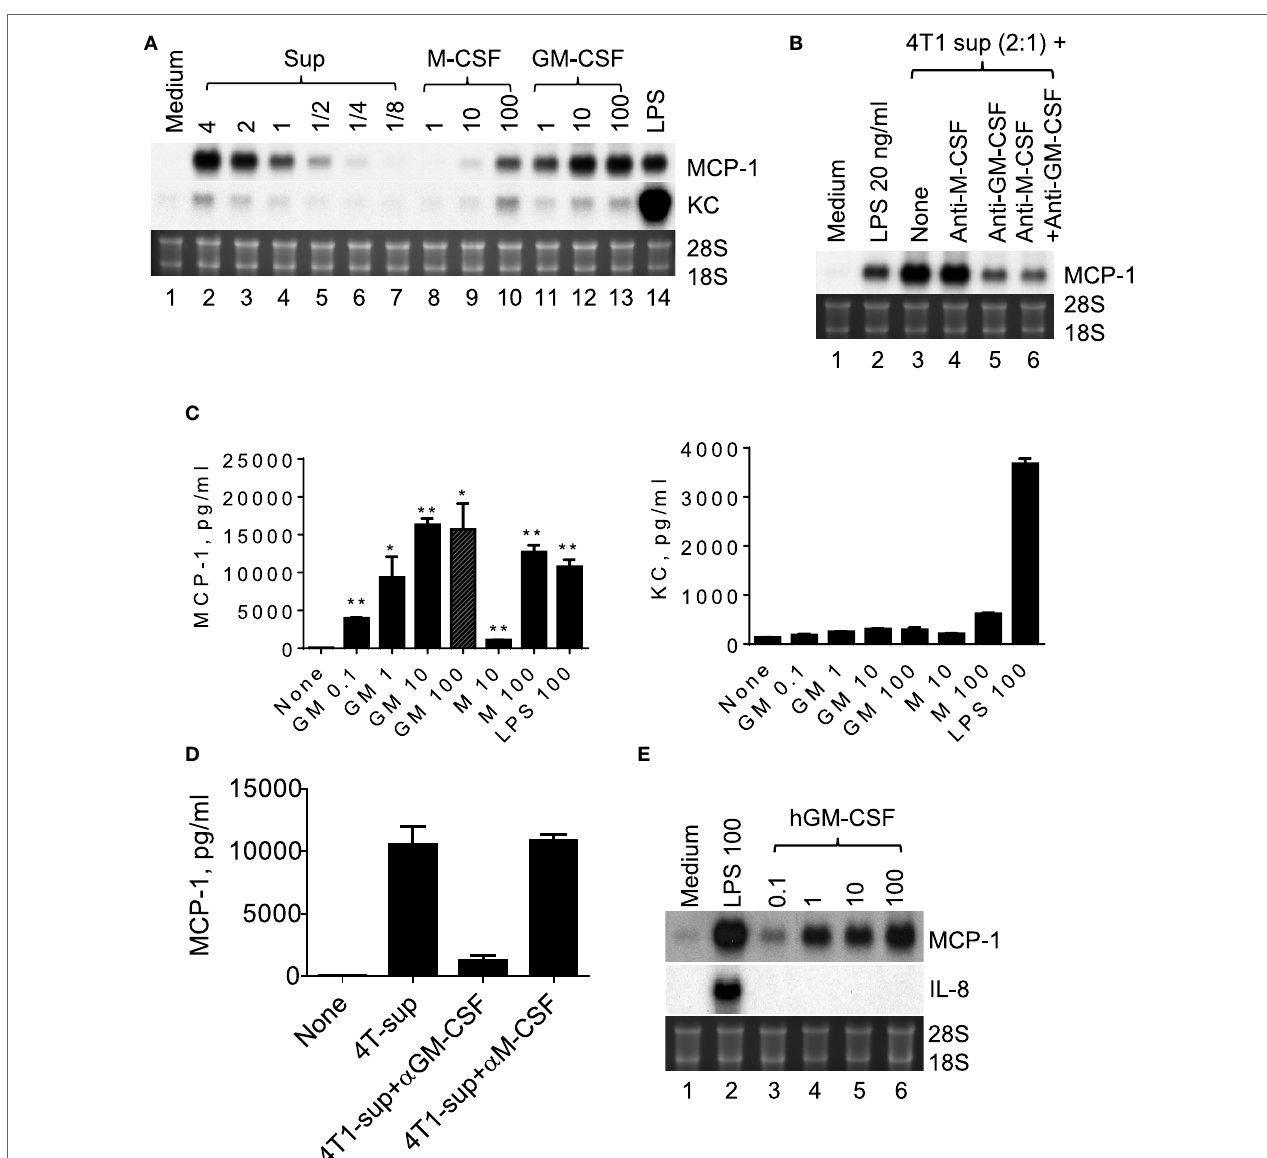
FigUre 4 | gM-csF produced by 4T1 cells is responsible for the McP-1 expression by macrophages. (a) Two and half million TG-induced PEC from WT mice were cultured for 4 h in the presence of different concentration of 4T1-sup, mouse recombinant M-CSF or GM-CSF for 4 h. Total RNA was isolated and subjected to Northern blotting. (B) Two and half million TG-induced PEC from WT mice were cultured for 4 h with 4T1-sup in the presence or absence of neutralizing antibody against mouse M-CSF or GM-CSF for 4 h. Total RNA was isolated and subjected to Northern blotting. (c) Two million TG-induced PEC from WT mice were cultured for 24 h in the presence of different concentrations of recombinant mouse GM-CSF, M-CSF, or LPS. Cell-free culture supernatants were obtained, and the concentration of MCP-1 or KC was measured by ELISA for MCP-1 and by Cytometric Bead Array for KC. The results are shown as the mean ± SD, n = 2. (D) Two million TG-induced PEC from WT mice were cultured for 24 h with 4T1-sup in the presence or absence of neutralizing antibody against mouse M-CSF or GM-CSF. Cell-free culture supernatants were obtained and the concentration of MCP-1 was measured by ELISA. The results are shown as the mean ± SD, n = 2. (e) Human monocyte-derived macrophages were cultured with 100 ng/ml LPS or different concentrations of recombinant human GM-CSG for 4 h. Total RNA was isolated and subjected to Northern